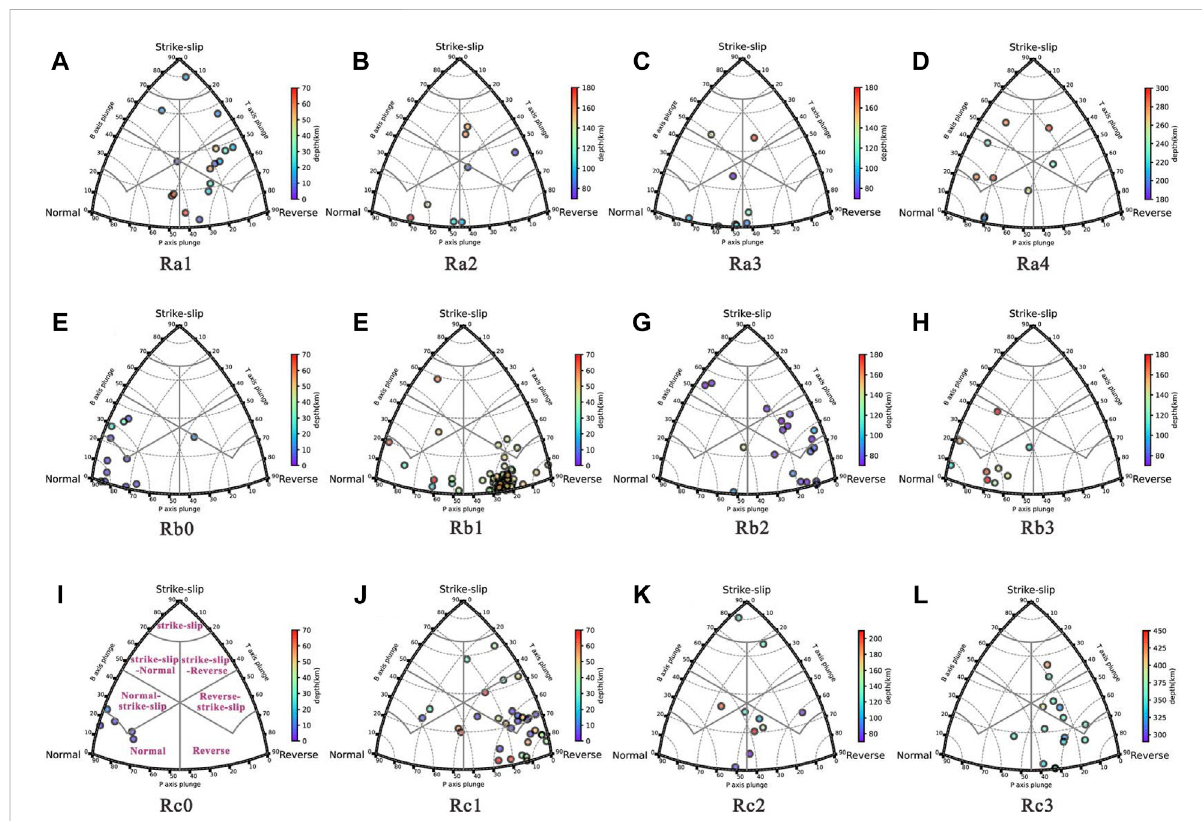
FIGURE 6 (A – L) : A ternary diagram representing the distribution of earthquake faulting characteristics at various pro fi les. Ternary diagrams representing the distribution of earthquake faulting characteristics at various pro fi les. It is plotted as a function of the orientation of the P, T, and B-axes for the thrust, normal, and strike-slip faulting earthquakes. The ternary classi fi cation is based on Frohlich (1992) and visualized using Álvarez-Gómez (2019). ThereadermayreferthepanelIforageneraldistributionofthefaultingregimesinaternaryclassi fi cation.Eventsarerepresentedbycolor fi lled circles based on depth (scale on the